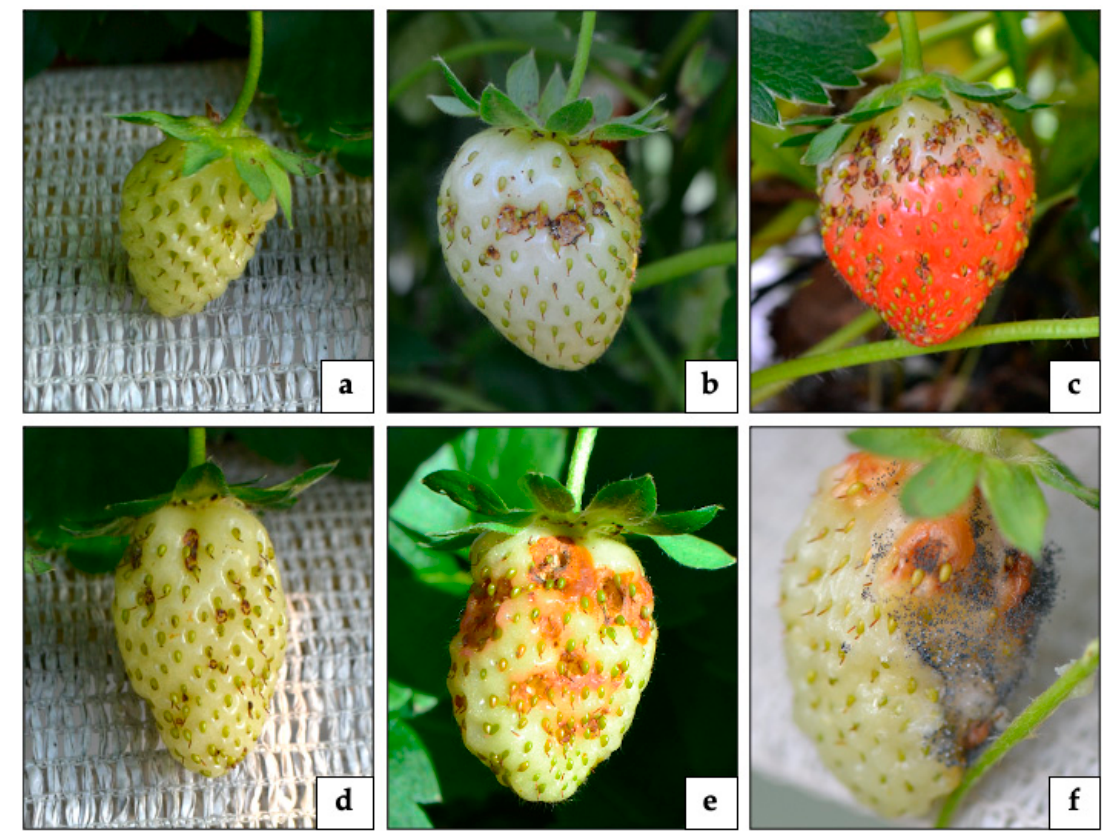
Figure 1. Damage caused by SBW adults on strawberry fruit at different stages: ( a ) small and green, ( b ) white, and ( c ) red strawberry; ( d ) immature malformed strawberry; ( e , f ) development of molds on damaged fruit (Tonina-Zanettin©).